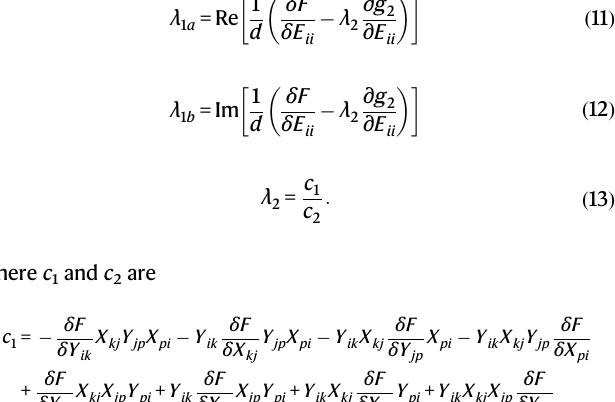
Fig.6|Annihilationofquarter-andhalf-chargeddisclinationsexhibitdifferent relaxation dynamics. Systems are initialized with ( a , b ) or without ( c , d ) a phase gradientbetweenthebulkandboundaryinannularcon fi nements,leadingtoeither two pairs of half-charged disclinations ( a ) or four pairs of quarter-charged dis- clinations ( c ). All parameters are as in Fig. 5. a The modulus ∣ ψ ∣ for a system initi- alizedtoproducetwopairsofhalf-chargeddisclinationsattime t =15 μ . b Temporal dependenceofthefreeenergydensity, Δ f = f − f eq forrepeatedsimulationswiththe a initialization. Black circles mark defect annihilation events. (inset) Temporal evolutionofdefectseparationforeachpairrelativeto t * ,thepairannihilationtime. Shading represents the standard deviation. c The ϕ fi eld for a system initialized to producefourpairsofquarter-chargeddisclinationsattime t =15 μ . d Sameas b but for quarter-charge annihilation